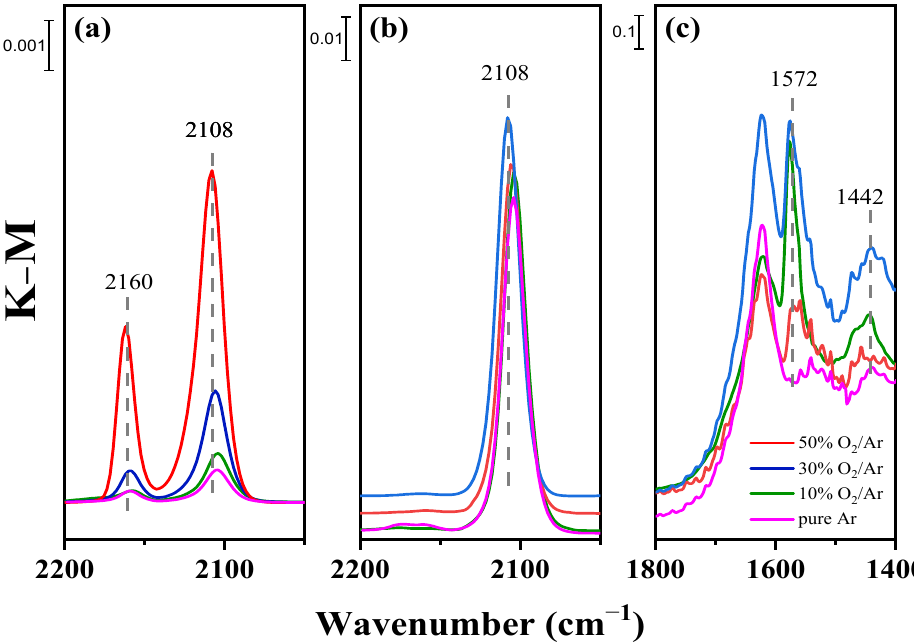
Figure 8. In situ DRIFT spectra of CO adsorption at exposure times of ( a ) 2 min at the band of 2050~2200 cm − 1 , ( b ) 7 min at the band of 2050~2200 cm − 1 and ( c ) 7 min at the band of 1400~1800 cm − 1 .